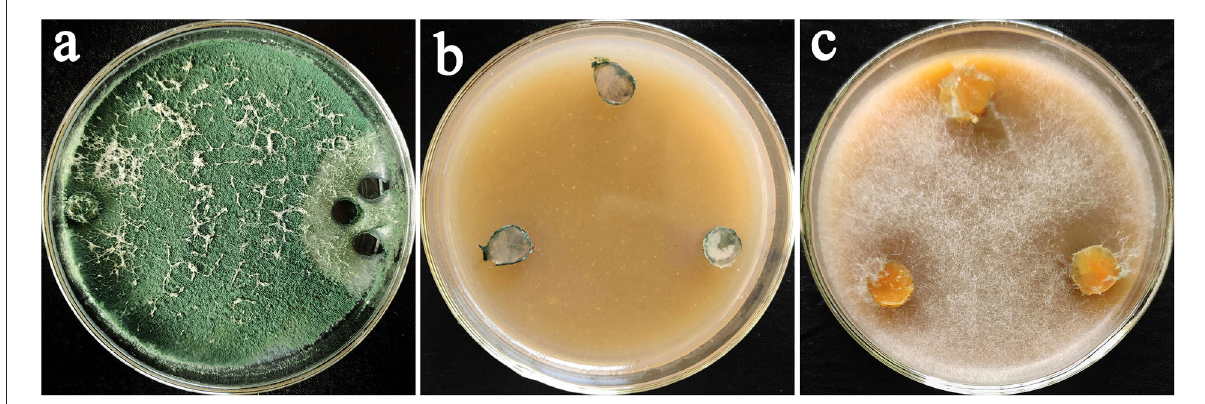
FIGURE2 Trichoderma antagonized and killed oomycetes. (a) Antagonism of T. asperellum Tv-1 on P. nicotianae ; (b) P. nicotianae could not form colonies on the selective medium after being parasitized by Tv-1; (c) pure P. nicotianae grew into colonies on the selective medium.